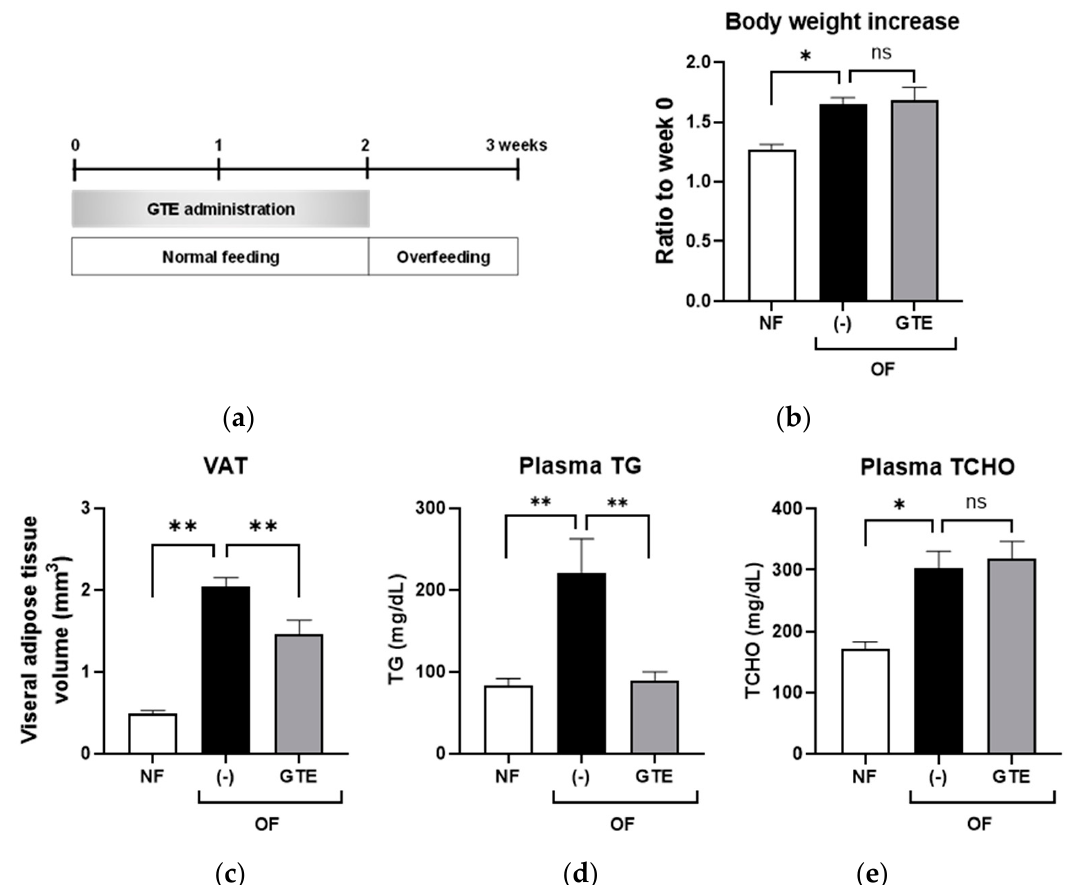
Figure 2. Preventive administration of green tea extract (GTE) reduces VAT volume and decreases plasma triglyceride (TG) levels in adult obese zebrafish. ( a ) Experimental design scheme using adult zebrafish, ( b ) change in body weight, ( c ) change in VAT volume measured by micro-CT, ( d ) change in plasma TG and ( e ) TCHO levels. * p < 0.05, ** p < 0.01, n = 5. Error bars indicate the standard deviation (SD). VAT, visceral adipose tissue; micro-CT, micro-computed tomography; TCHO, total cholesterol.